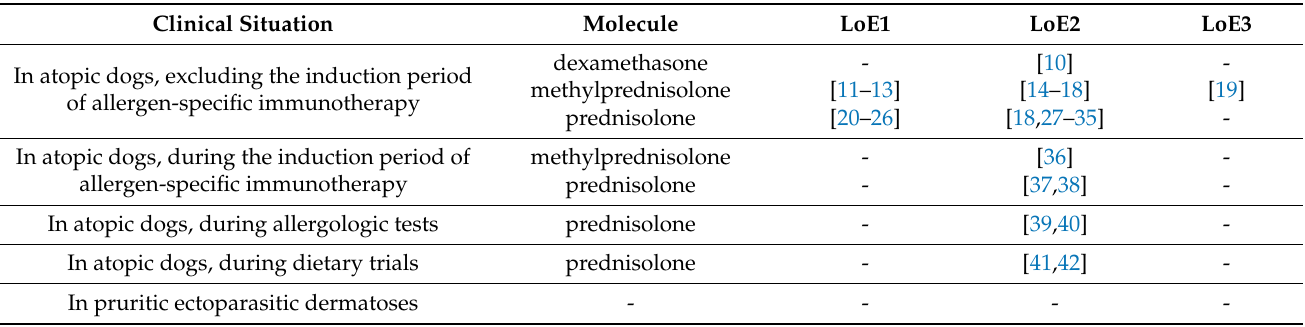
Table 1. Level of evidence (LoE) in an individual study of the use of systemic